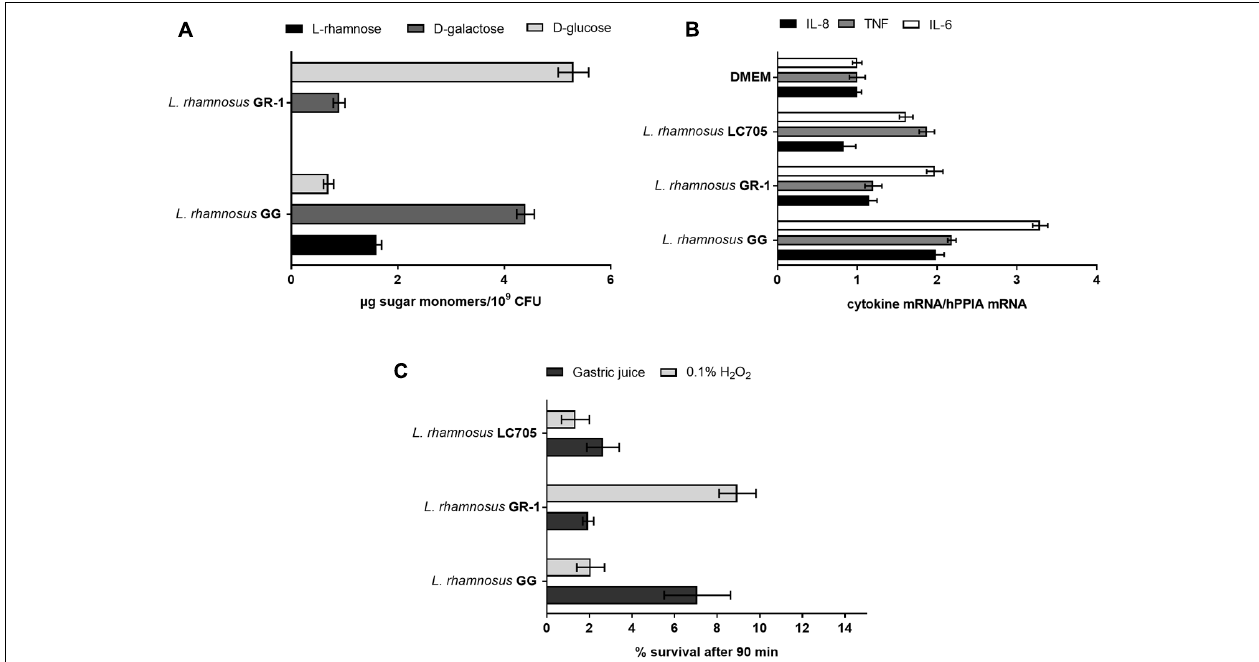
FIGURE 6 | Phenotypic comparison of L. rhamnosus GG, L. rhamnosus GR-1, and L. rhamnosus LC705. (A) EPS monomer composition analysis of L. rhamnosus GG versus L. rhamnosus GR-1. (B) IL-8, TNF and IL-6 mRNA induction in VK2/E6E7 epithelial cells after incubation for 1 h with L. rhamnosus GG, L. rhamnosus GR-1, and L. rhamnosus LC705. (C) Stress resistance of L. rhamnosus GG, L. rhamnosus GR-1 and L. rhamnosus LC705 in simulated gastric juice and 0.1% H 2 O 2 , represented as survival after 90 min